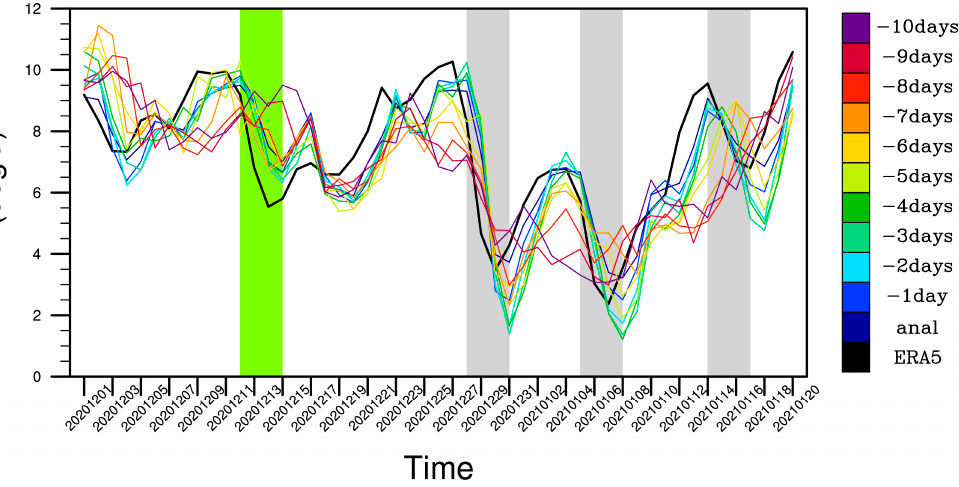
Figure 6. Time series of t2m in observations and forecasts with different lead times. The green fill in the figure represents the “1212” event. The gray fills in the figure represent the “1228”, “0105”, and “0114” events.